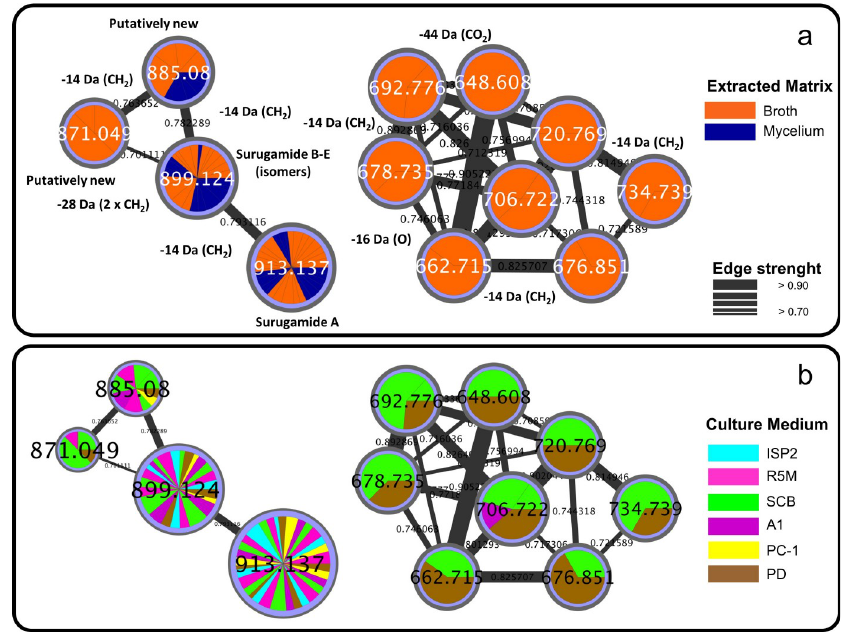
different matrix (broth/mycelium); b) color-code discriminates nodes occurring in extracts obtained from the different culture medium.